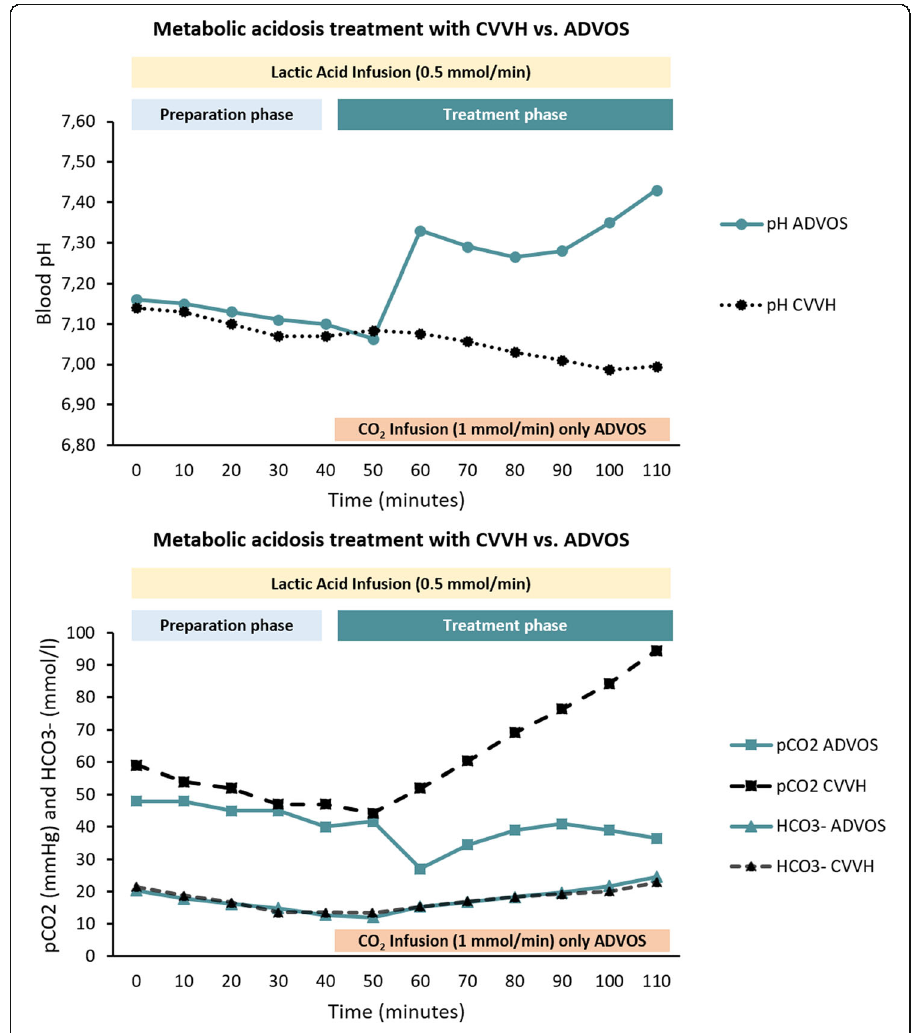
Fig. 5 Comparison of the course of blood pH (up), HCO 3 − , and pCO 2 (bottom) during treatments with ADVOS and CVVH. A metabolic acidosis was triggered in blood reaching baseline values before treatment of pH < 7.2, HCO 3 − < 14 mmol/l, and pCO 2 of 45 mmHg (preparation phase). Then, for 1 h, either a conventional hemofiltration using a commercially available substitution fluid with 35 mmol/l bicarbonate or a treatment with ADVOS multi with a dialysate pH of 9.00 was performed. Lactic acid was continuously supplied to maintain lactate levels over 5